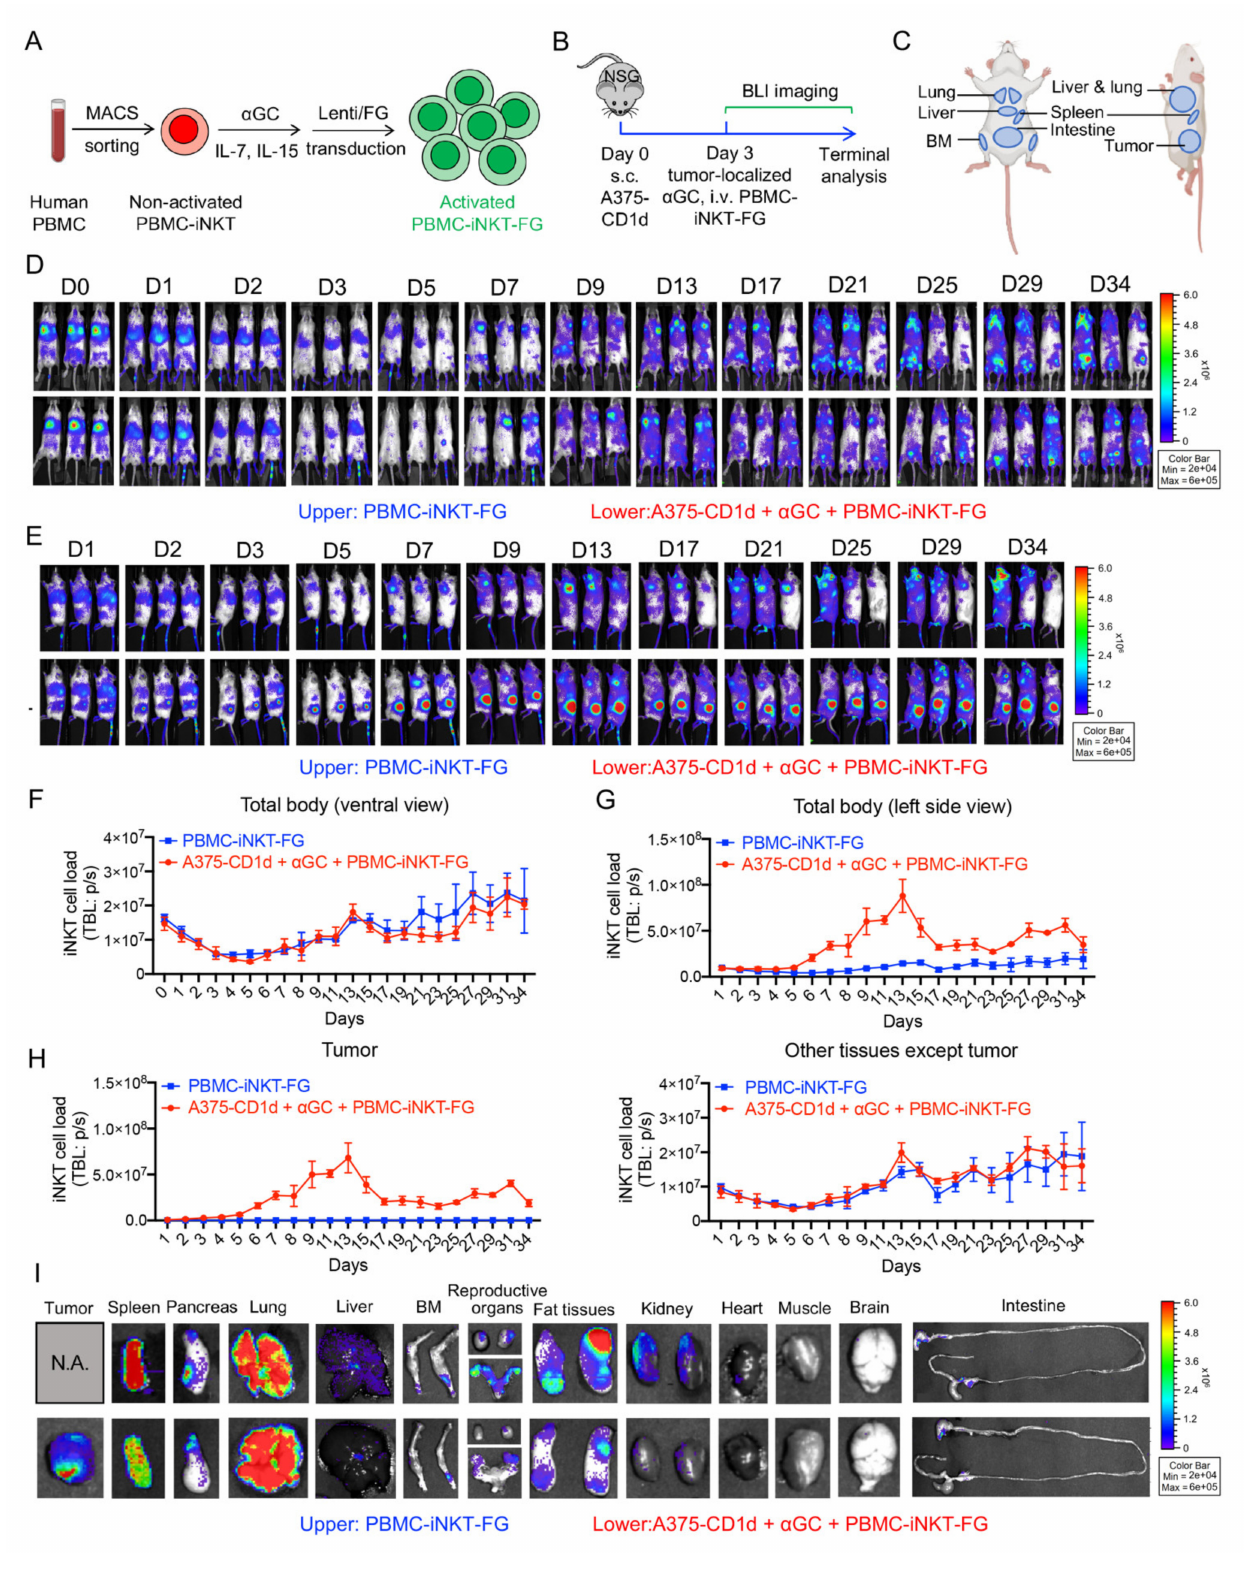
Figure 5. In vivo pharmacokinetics/pharmacodynamics (PK/PD) study of PBMC-iNKT cells in an A375-CD1d human melanoma xenograft NSG mouse model. ( A ) Generation of PBMC-iNKT cells overexpressing FG. ( B ) Experimental design. ( C ) The templates showing the distribution of tissues in the experimental mice from the ventral and left side views. BM, bone marrow. ( D ) BLI